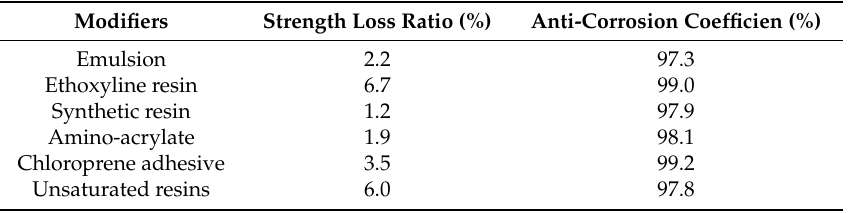
Table 5. Durability of modified crumb rubber concrete.